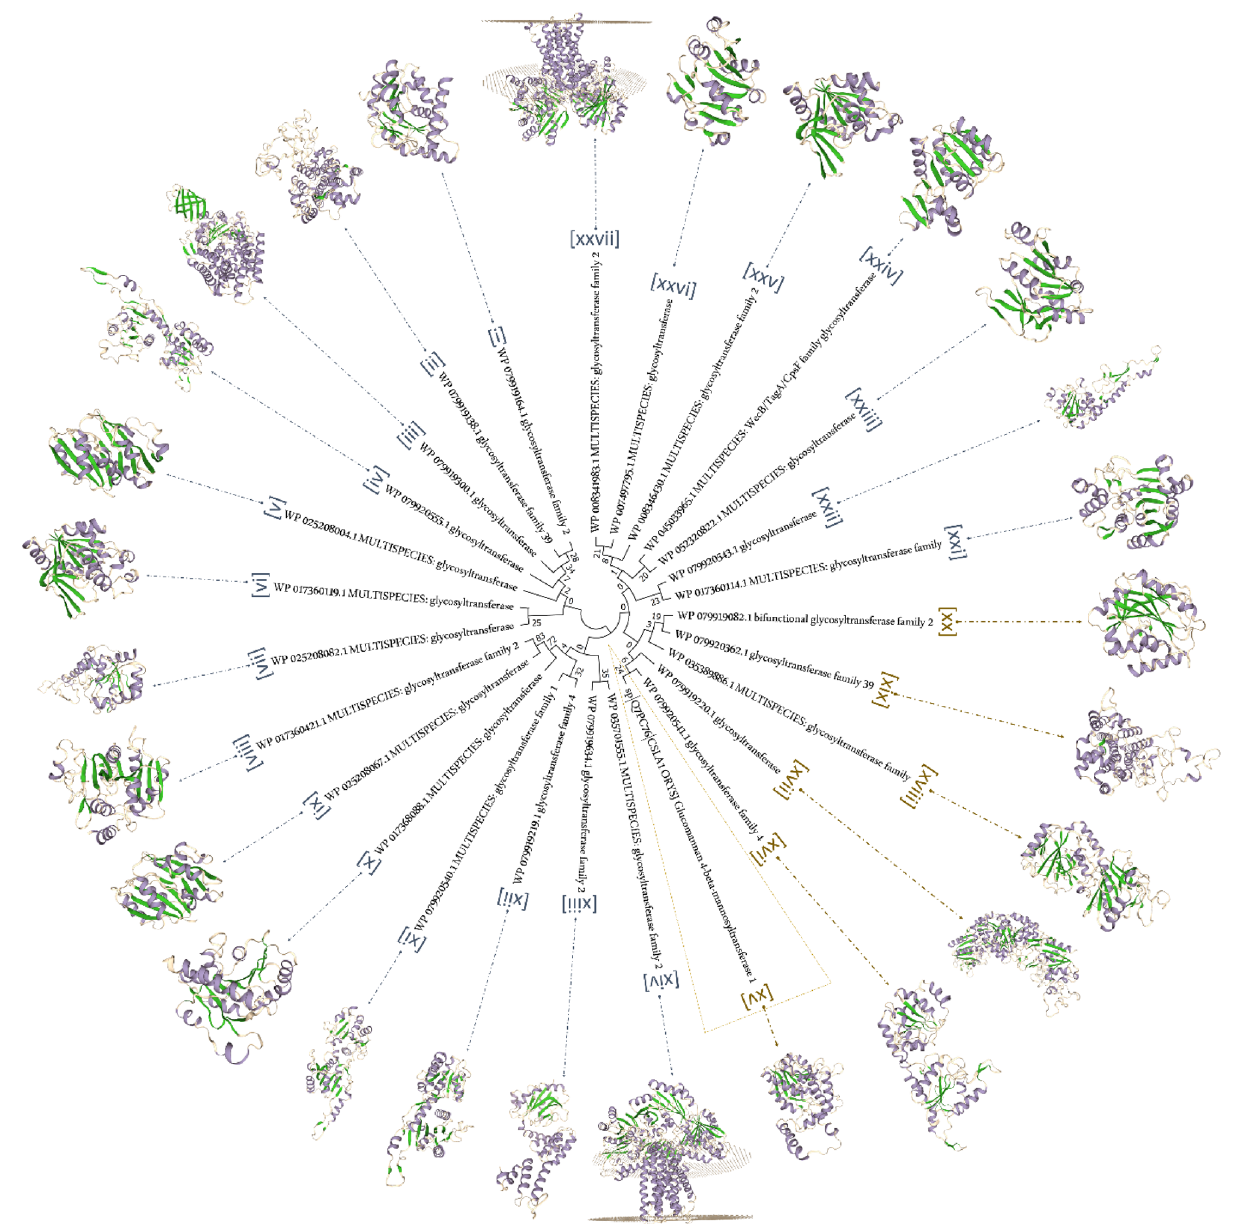
with the close neighbor interchange inference method in MEGA